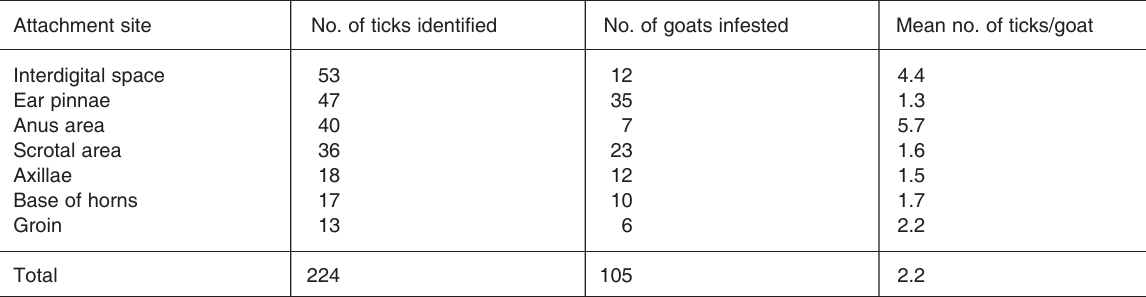
TABLE 2 The numbers of tick collected from various attachment sites of all the goats in the study areas Attachment site Interdigital space